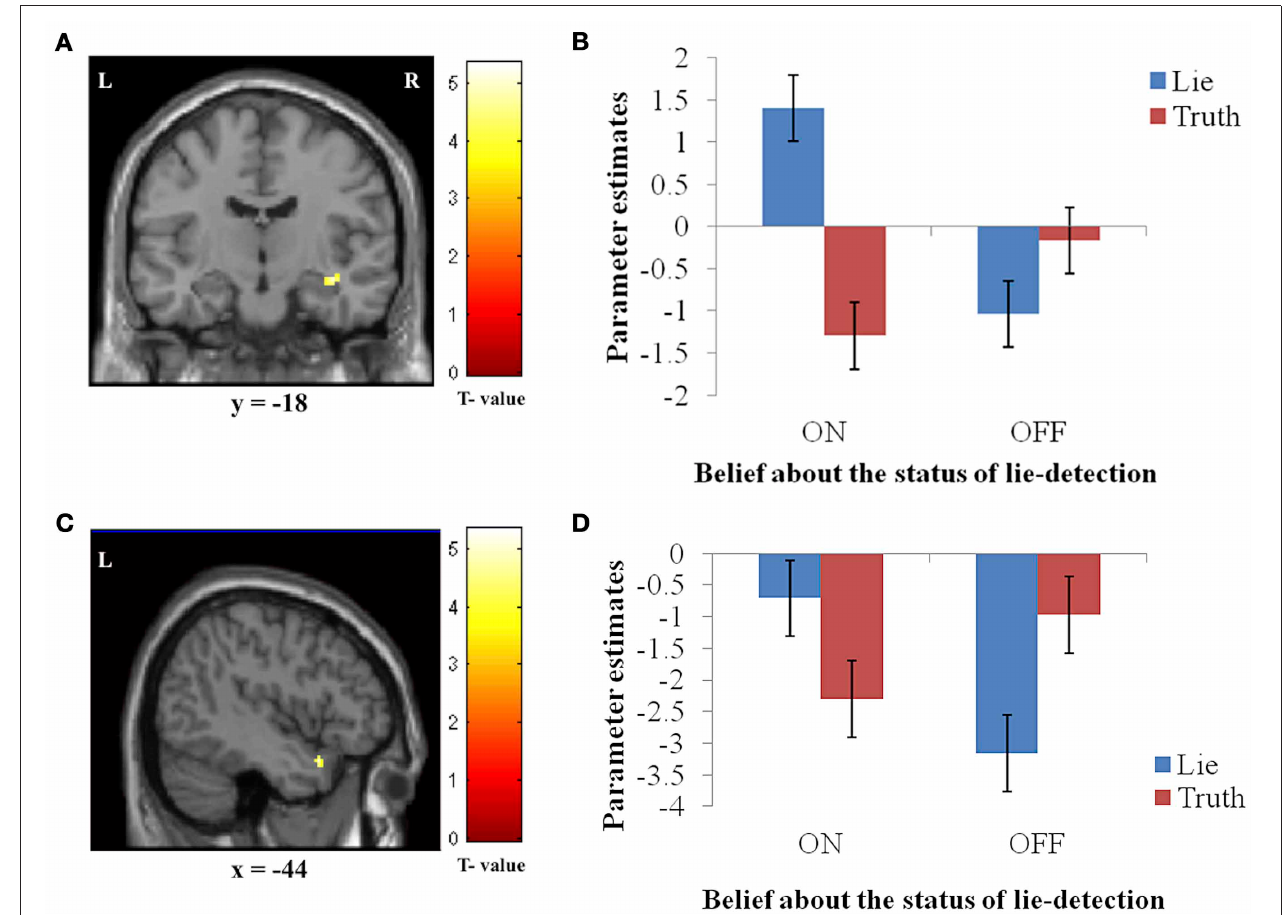
FIGURE 4 | The interaction between response type (true or false) and belief about the lie-detector (on or off). Panels on the left show the activation cluster and panels on the right show parameter estimates in the activation cluster in the right hippocampus/parahippocampalgyrus ( A and B )